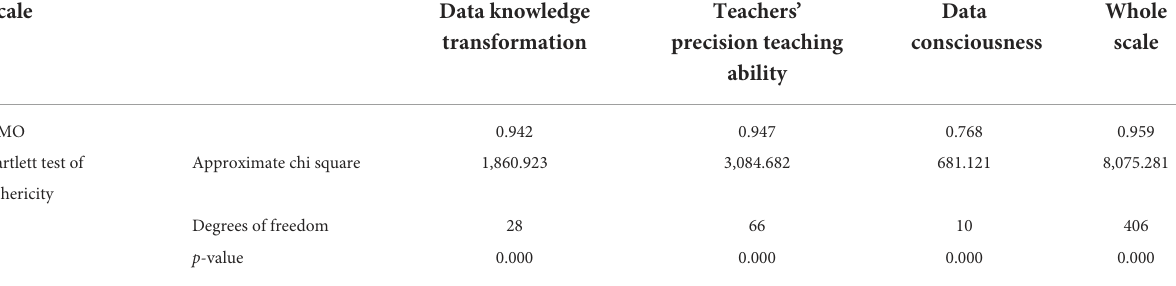
TABLE 3 KMO and Bartlett